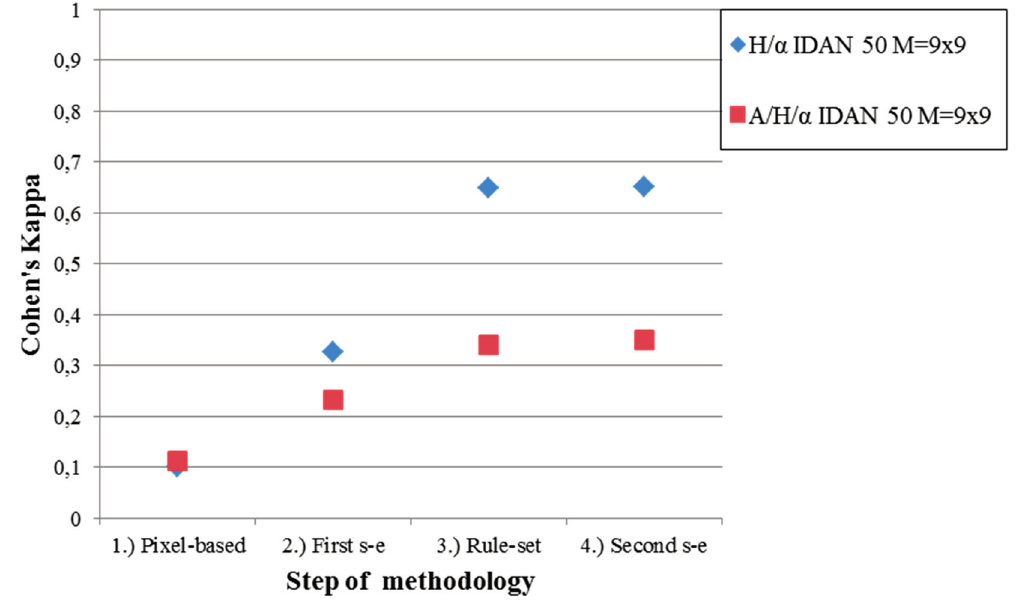
Figure 9. Development of the Cohen’s Kappa coefficient for the OBIA improvements (for the best results of the pixel-based PolSAR classification) based on H/ α or A/H/ α , respectively (for the first TerraSAR-X acquisition (5 September 2010)).